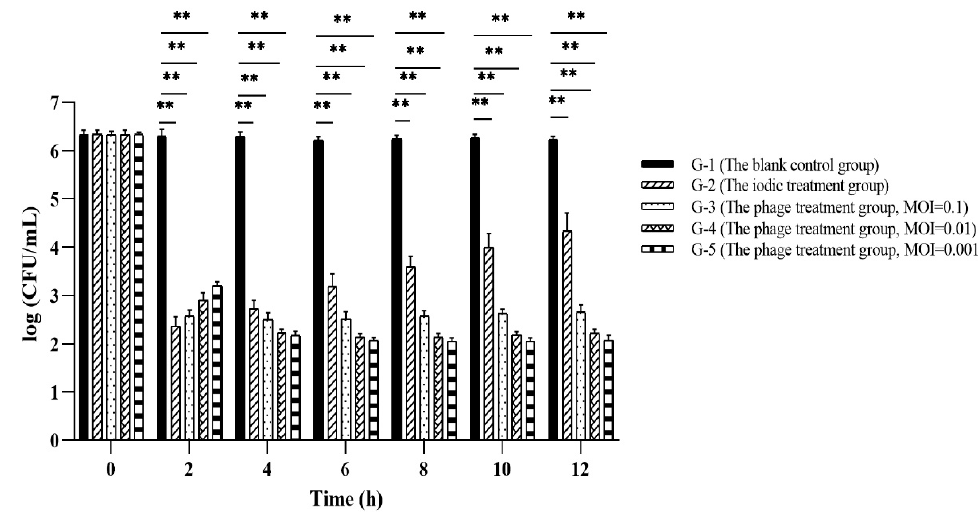
Figure 10. The result of phage PVA23 application in laboratory shrimp culture trials. **, p < 0.01.